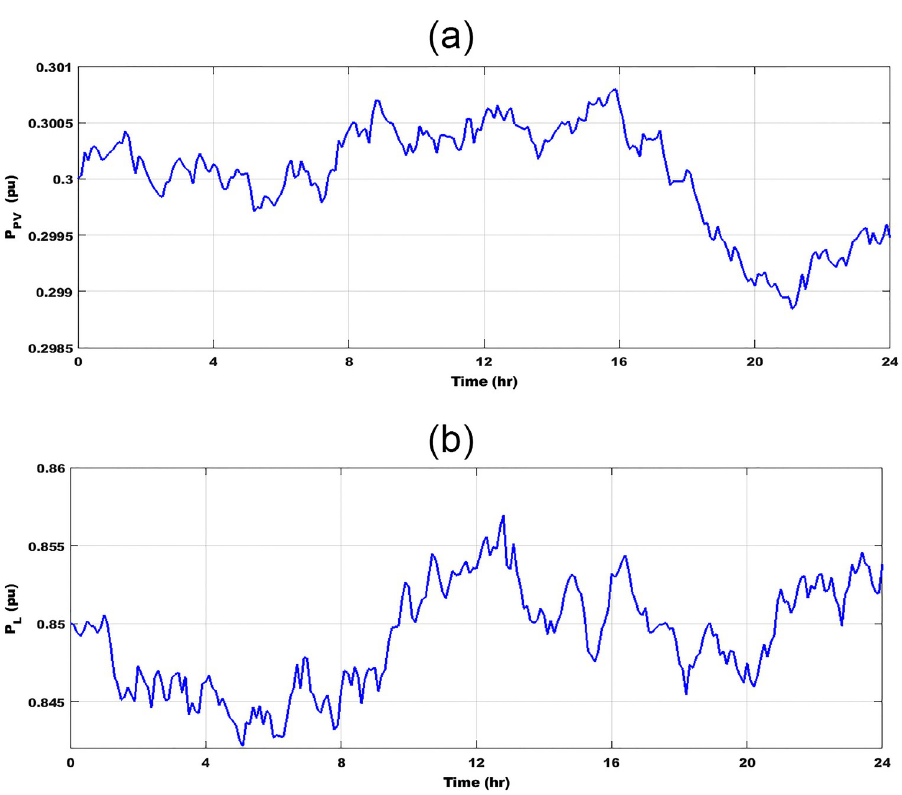
Fig 10. Changing in (a) PV Power; (b) Random demand